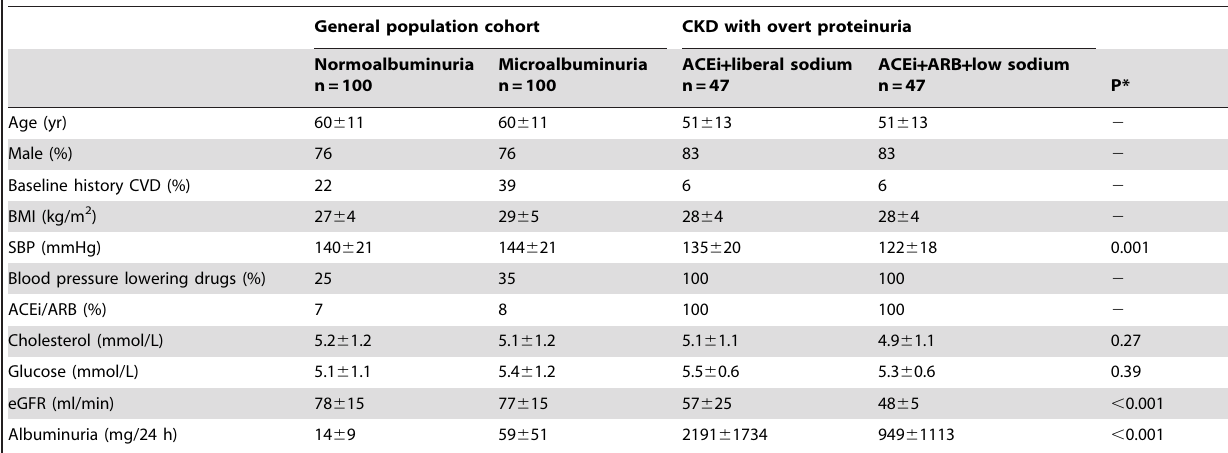
Table 3. Baseline characteristics of general population